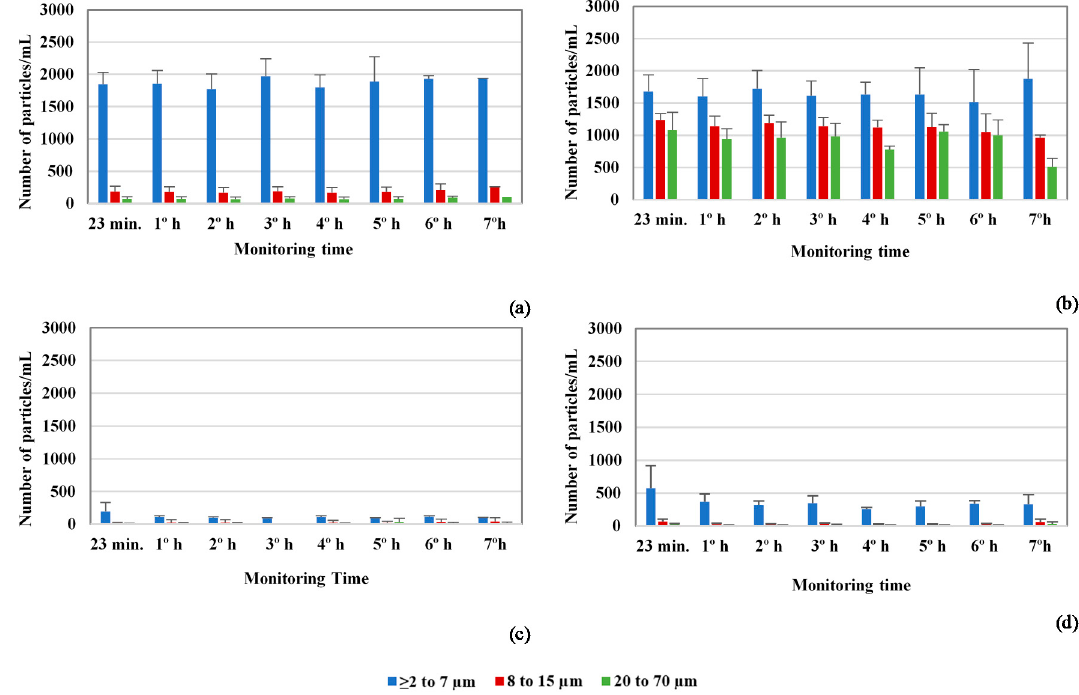
Figure 4. Average particle count: ( a , c ) raw water and filtered water, respectively, in experiments with low turbidity raw water; ( b , d ) raw water and filtered water, respectively, in experiments with higher turbidity raw water. Error bars represent the standard deviation from average particle count.